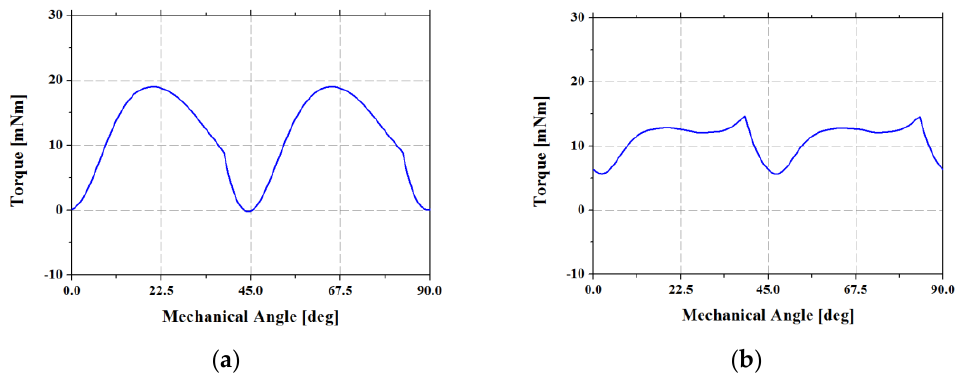
Figure 18. Comparison of the torque waveforms of the base and proposed models: ( a ) base model; ( b ) proposed model.